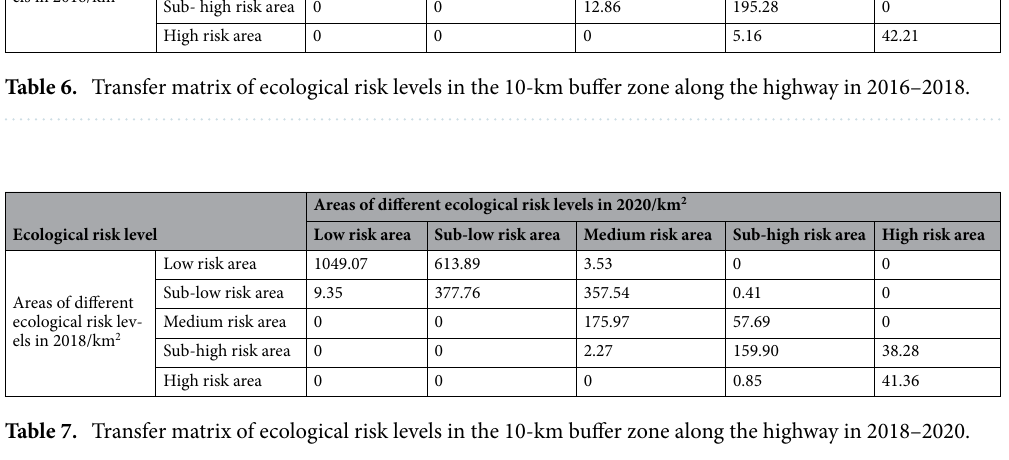
Table 7. Transfer matrix of ecological risk levels in the 10-km buffer zone along the highway in 2018–2020.